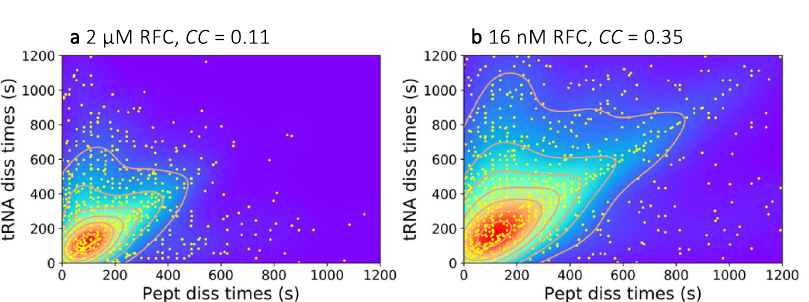
Fig. 4 Ataluren effects on RFC-dependent termination of polypeptide synthesis. Cumulative distributions of ( a ) peptide and ( b ) tRNA dissociation times at indicated RFC concentrations, one also with 1 mM ataluren. Each cumulative distribution is constructed from ≥ 300 kinetic traces. Rates of dissociation of ( c ). peptide and ( d ). tRNA as a function of RFC concentration at different fi xed ataluren concentrations. Error bars are ± s.e.m. for n = 250 – 750 trials. Normalized plots of ensemble experiments showing single exponential fi ts (solid lines) of decimated smoothed raw data (points) of atto647 pentapeptide release reaction measured by fl uorescence anisotropy decay vs. time at 25 °C. e At indicated RFC concentrations. The control shows the near constancy of observed anisotropy in the absence of added RFC or ataluren. f At an RFC concentration of 0.0625 µ M and varying ataluren concentrations. g The rates of dissociation of atto647 pentapeptide in ensemble experiments as a function of free RFC concentration at varying ataluren concentrations. Error bars are average deviation (a. d.) for n = 2 – 6 independent determinations. Values of n for each point are presented in Supplementary Table 5. h Ataluren inhibition of normalized rates of dissociation of atto647 pentapeptide as measured by single molecule (red) and plate reader (black) assays. [eRF1], 32 nM; [eRF3], 0.2 µ M and 0.8 µ M in the single molecule and ensemble assays, respectively. Error bars are ± s.e.m. n ≥ 250 trials (single molecule) and ± a.d., n = 2 independent determinations (plate reader). i Rates of dissociation of atto647 labeled and unlabeled pentapeptide as measured by millipore fi ltration, calculated using both fi ltrate and fi lter retained values. Error bars are ± s.d., n = 8 independent measurements for all points except for the 4 min measurements, for which n = 11. [eRF1], 0.2 µ M; [eRF3], 0.8 µ M; POST5, 0.05 µ M. j Ataluren inhibition of peptide and tRNA release when added at different times (4 – 25 s) following RFC addition to Stop-POST5. [RFC], 0.08 µ M; [Ataluren], 1 mM. Values at zero-time correspond to simultaneous addition of ataluren and RFC. Error bars are ±s.e.m. for n ≥ 200 trials. Source data for all panels are provided as a Source Data fi le.